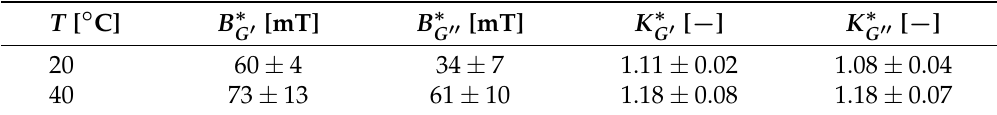
Table 2. Fit parameters for Equation (5) for the subplots shown in Figure